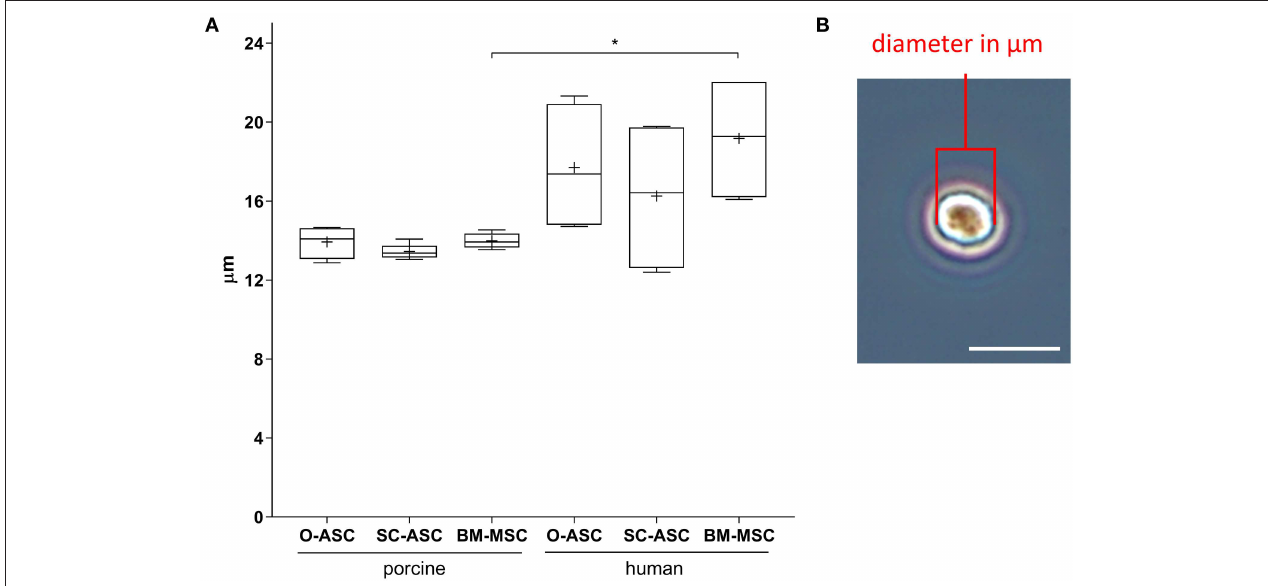
FIGURE 4 | Cell size analysis. Diameters of lifted cells were measured in passage 2–3 cells for the three cell lines (O-ASC, SC-ASC, and BM-MSC). (A) Cell diameters expressed in µ m. Error bars = SD. One-way ANOVA with Tukey post-test. * p < 0.05. (B) Representative microscopic image of one cell in the hemocytometer showing how diameters were manually measured with ImageJ (NIH). Bar = 20 µ